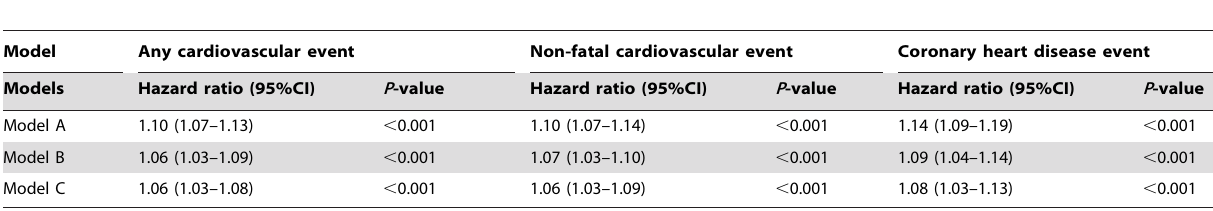
Table 3. Hazard ratios (95%CI) for any cardiovascular, non-fatal cardiovascular and coronary heart disease events per hour/day increase in television viewing in 12,608 men and women in EPIC Norfolk,